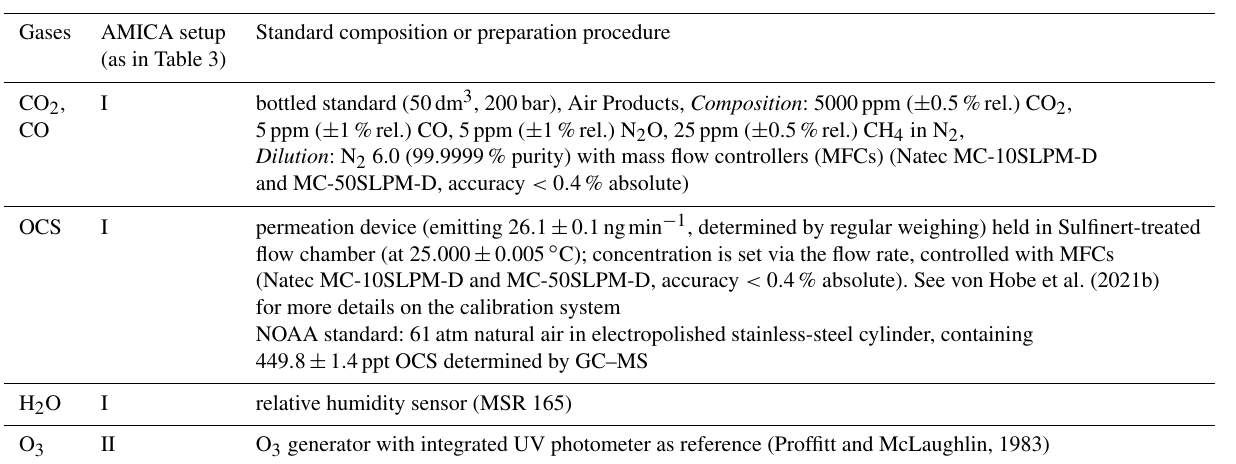
Table 5. Compilation of bottled standards and procedures to prepare standards used for laboratory tests and calibrations of the AMICA setups described in this paper.